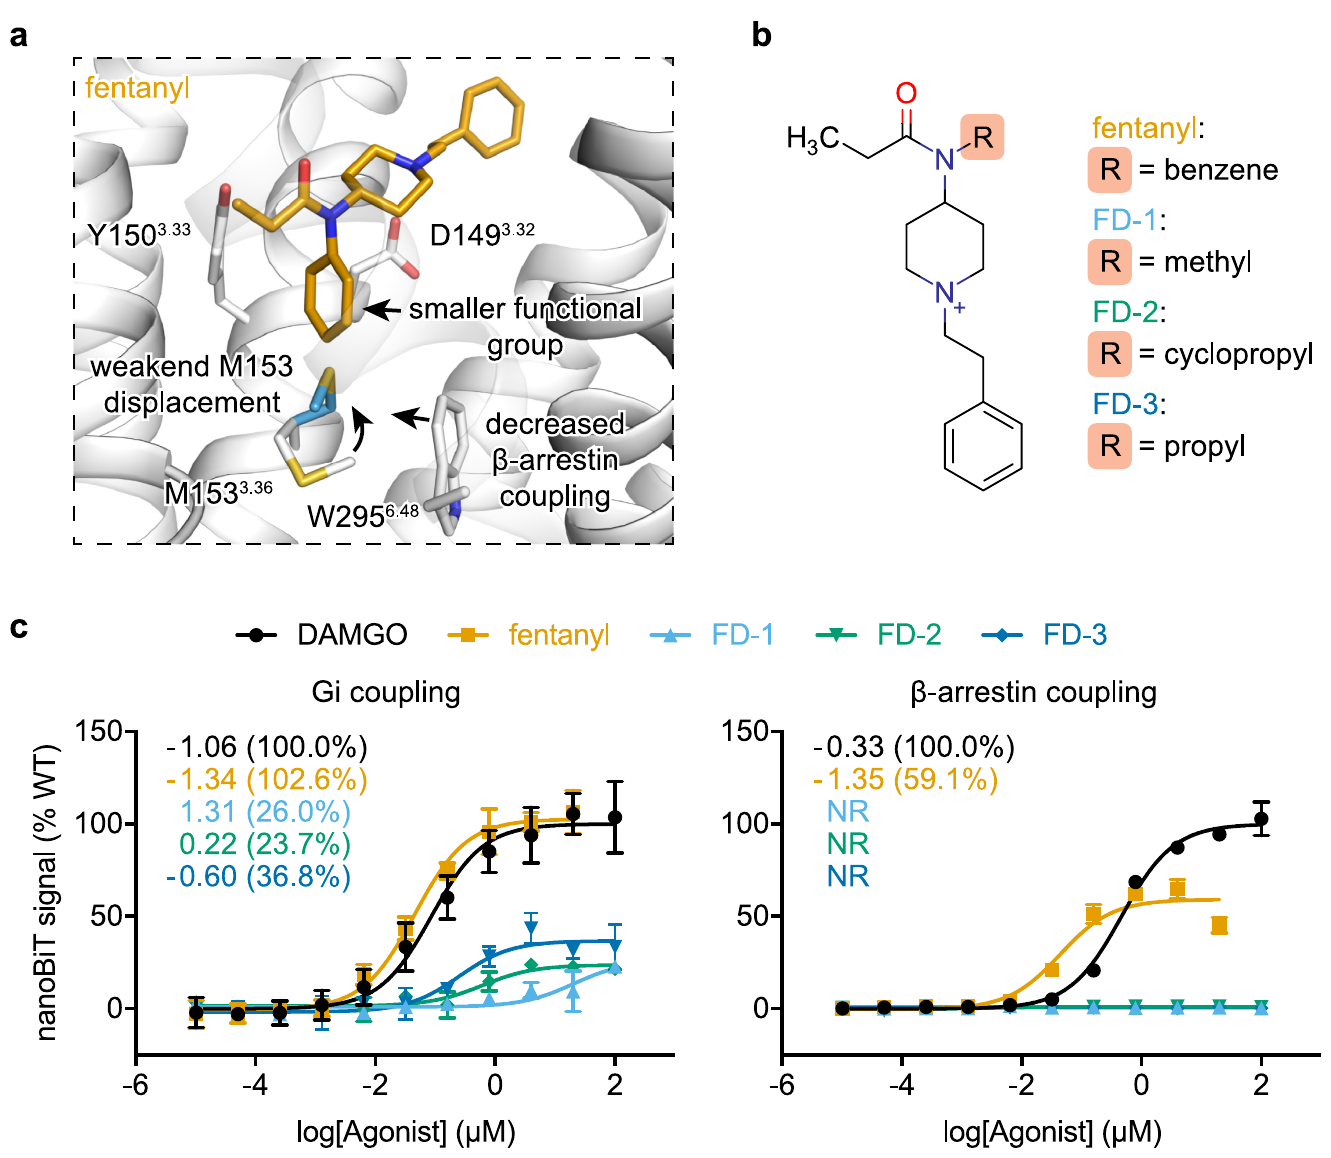
Fig 6. Fentanyl derivatives with no β -arrestin signaling. a-b, Structure based rational and chemical structure of newly synthesized fentanyl derivatives. c, Gi complex and β -arrestin coupling dose-response curve for DAMGO, fentanyl, and compounds FD1-3 measured by nanoBiT direction interaction assays. EC 50 and maximal coupling efficacy compared to DAMGO are shown. Values and error bars reflect mean ± s.e.m. normalized to DAMGO of three technical